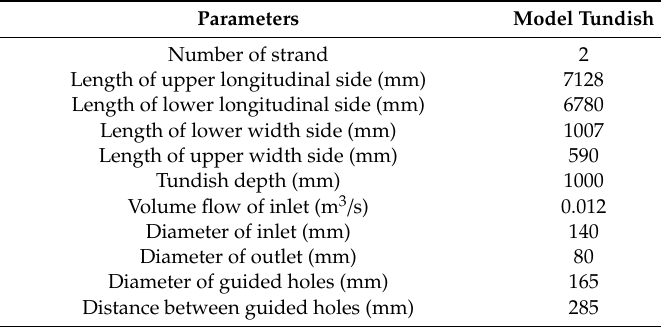
Table 1. Parameters in the model